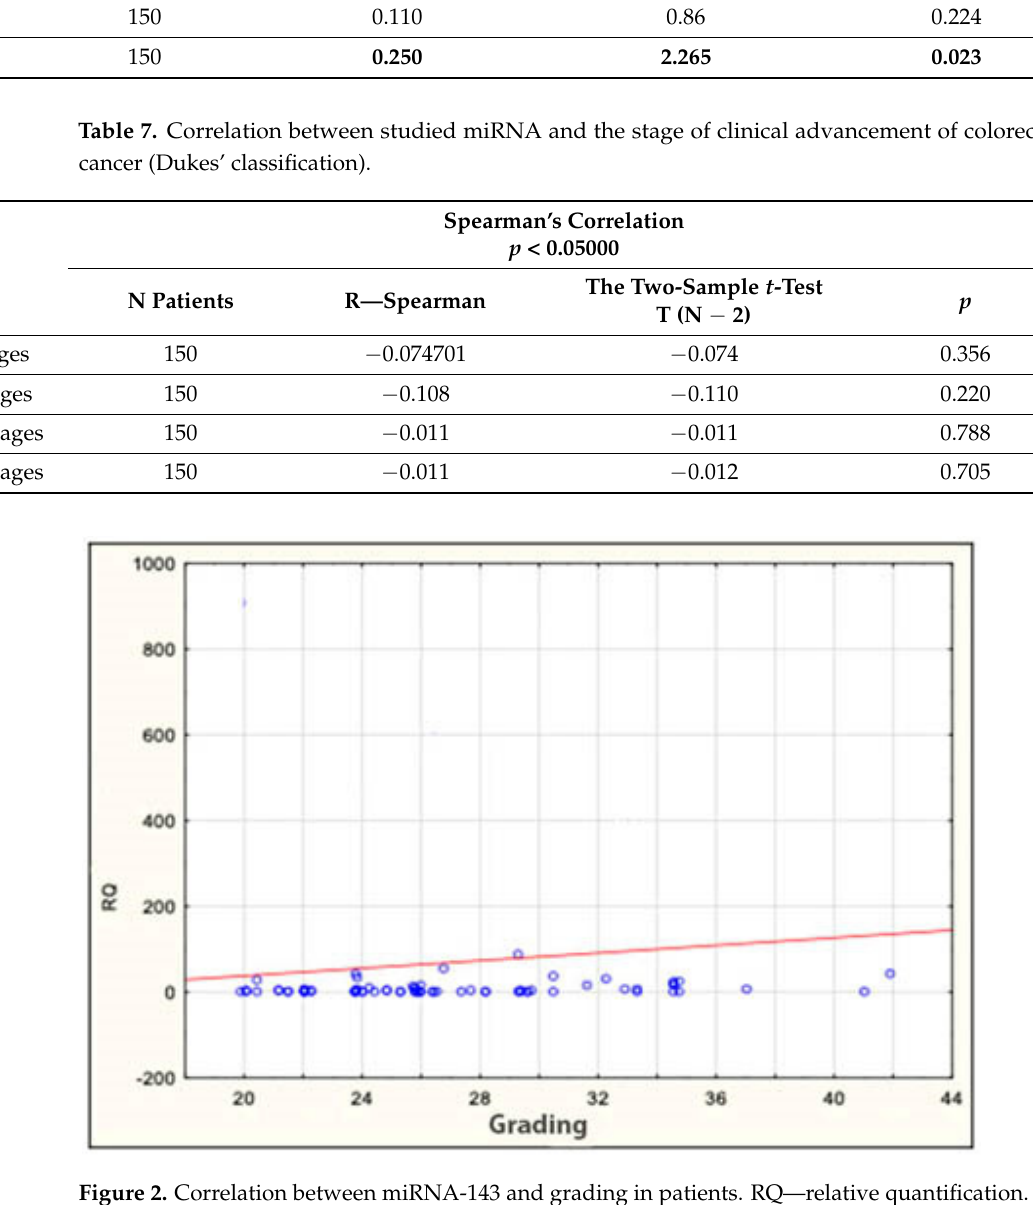
Figure 3. ROC curve for the ability of miR ‐ 143 to differentiate between colorectal cancer and positive colorectal cancer lymph nodes.